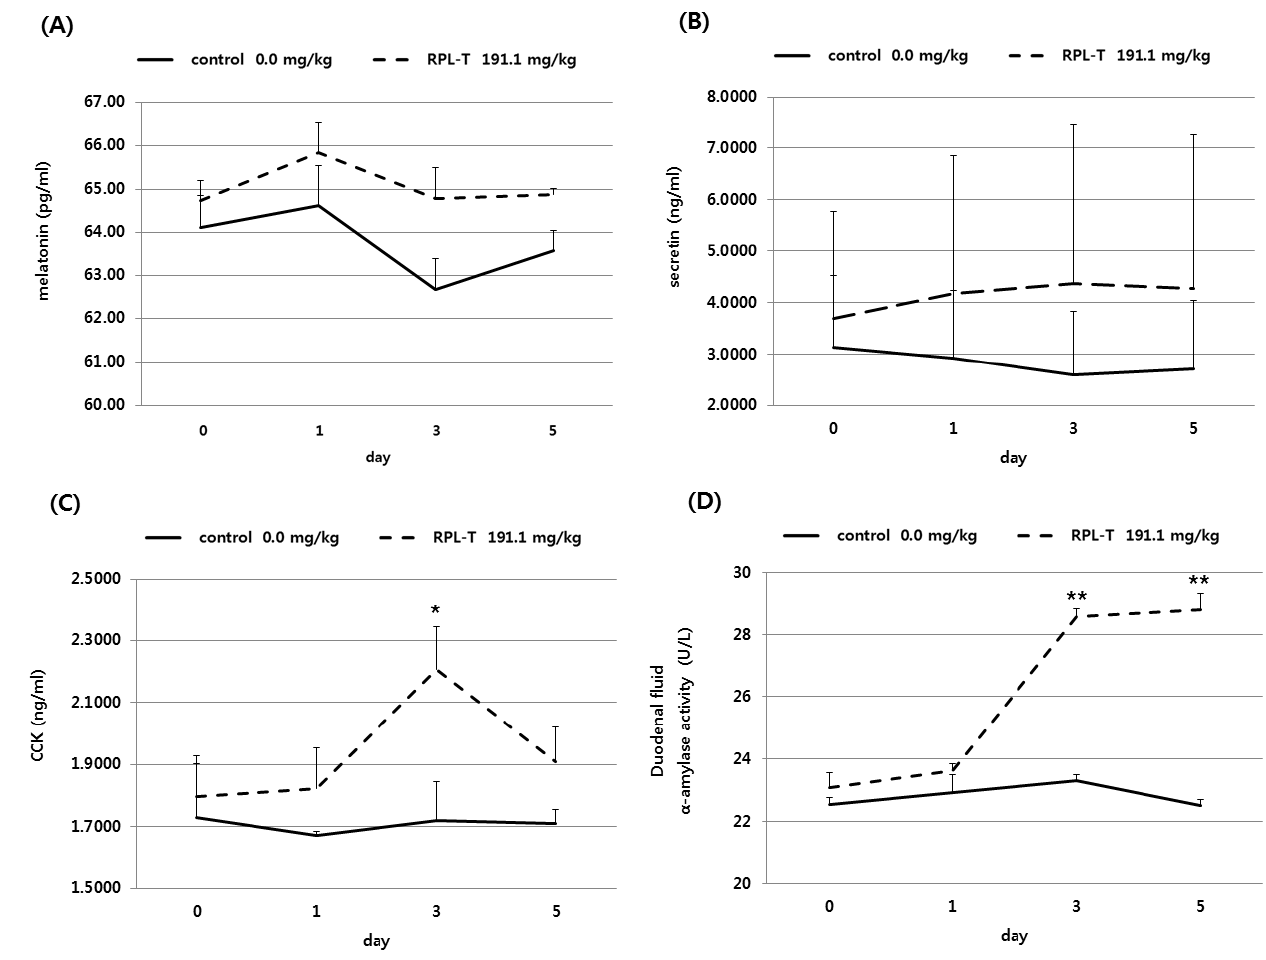
Figure 1. Changes in the levels of serum melatonin (A), secretin (B), CCK (C), and duodenum α -amylase (D) in Korean native steers fed RPL-T. CCK, cholecystokinin; RPL-T, rumen-protected L-tryptophan. Mean±standard error, * p<0.05, ** p<0.01 (Student’s paired t-test, control vs RPL-T at 191.1 mg/kg body weight). — Control group, - - - RPL-T